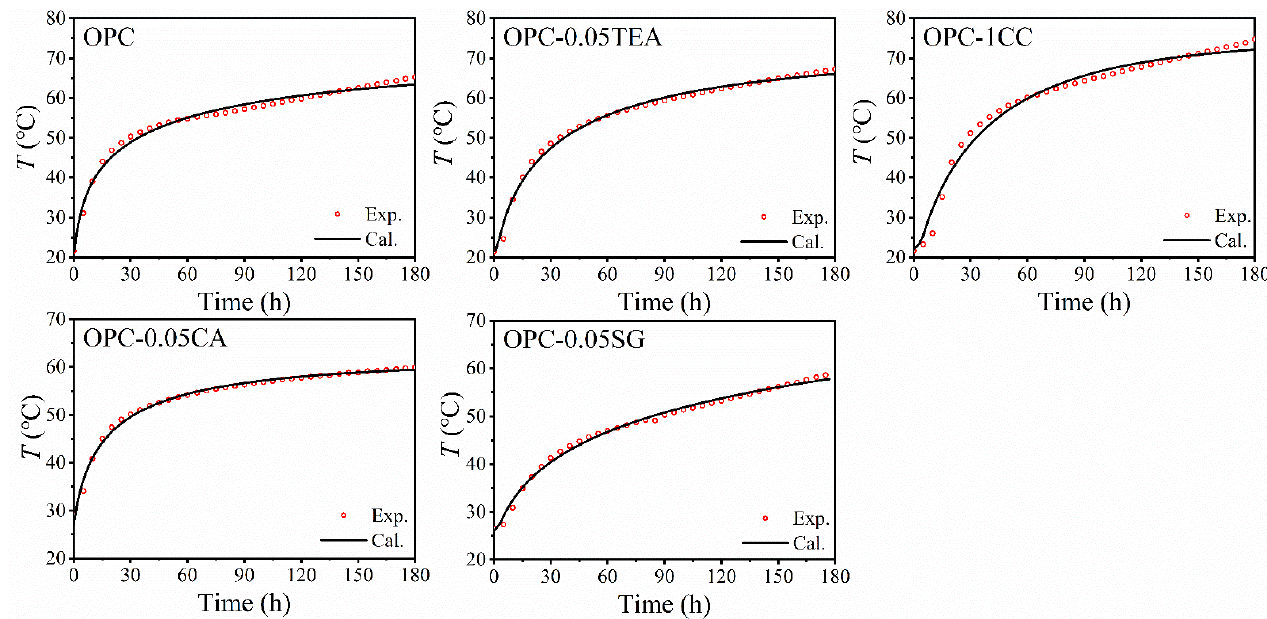
Figure 8. The predicted results of adiabatic temperature rise of concrete with different set-control- ling admixtures.